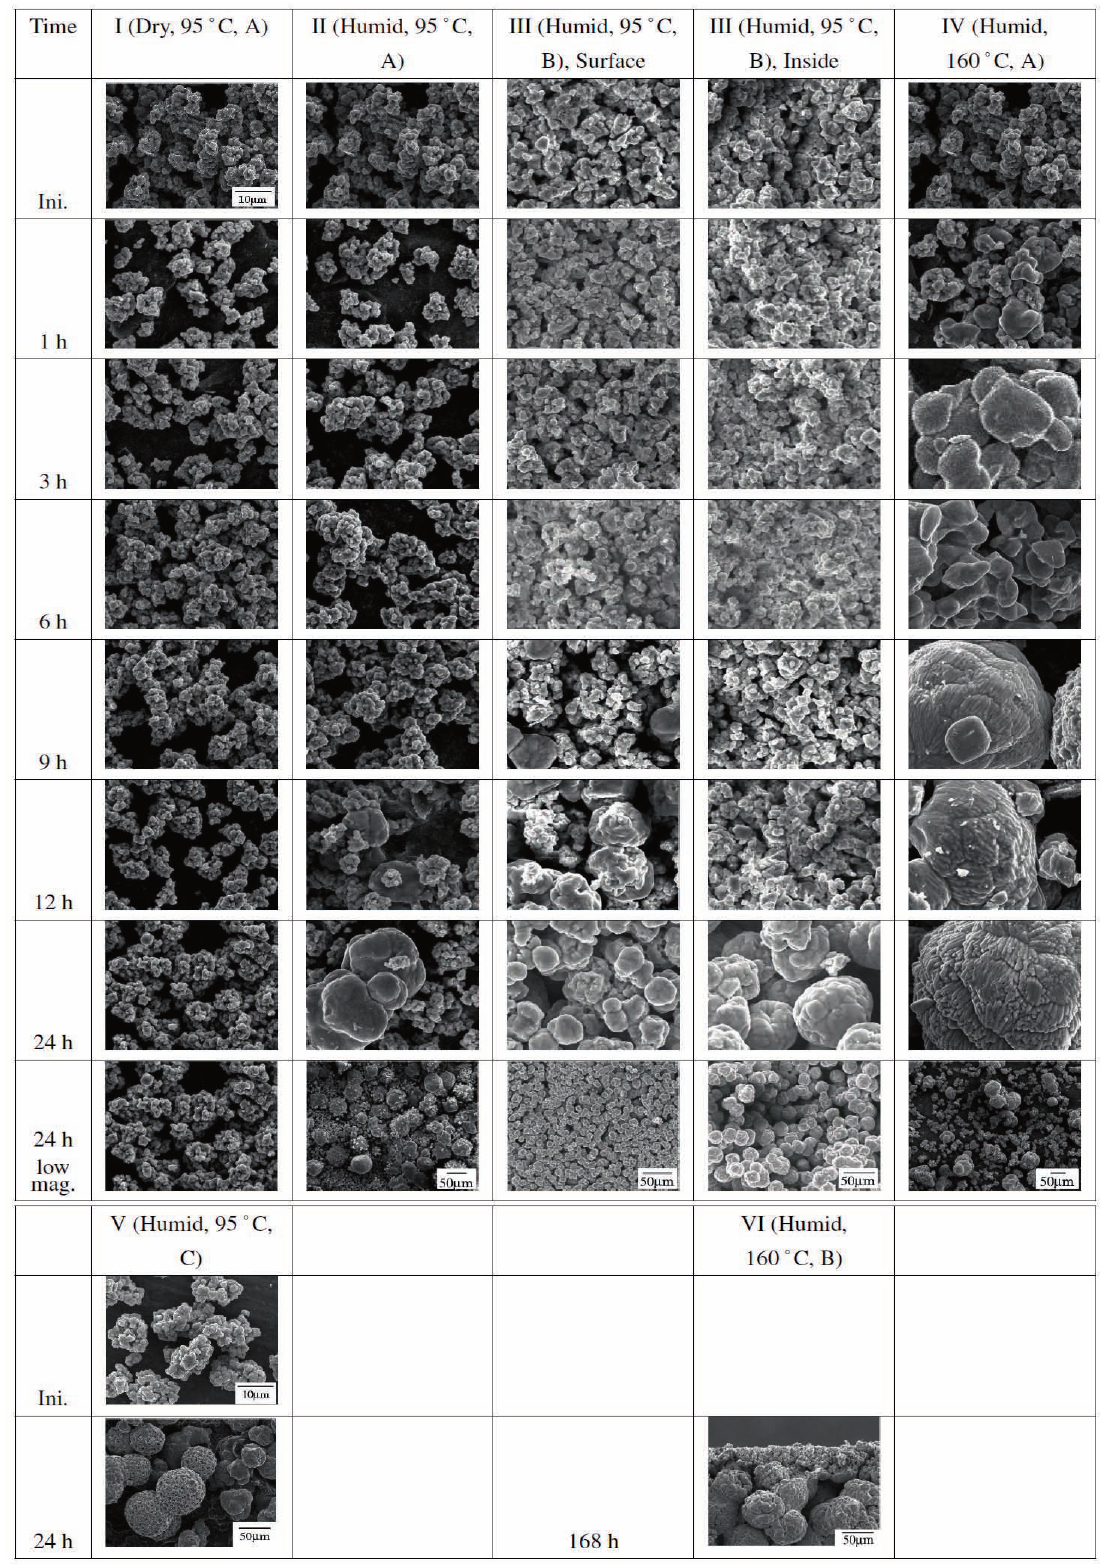
Figure 3. The SEM images of the samples obtained in all the experimental conditions and the retention